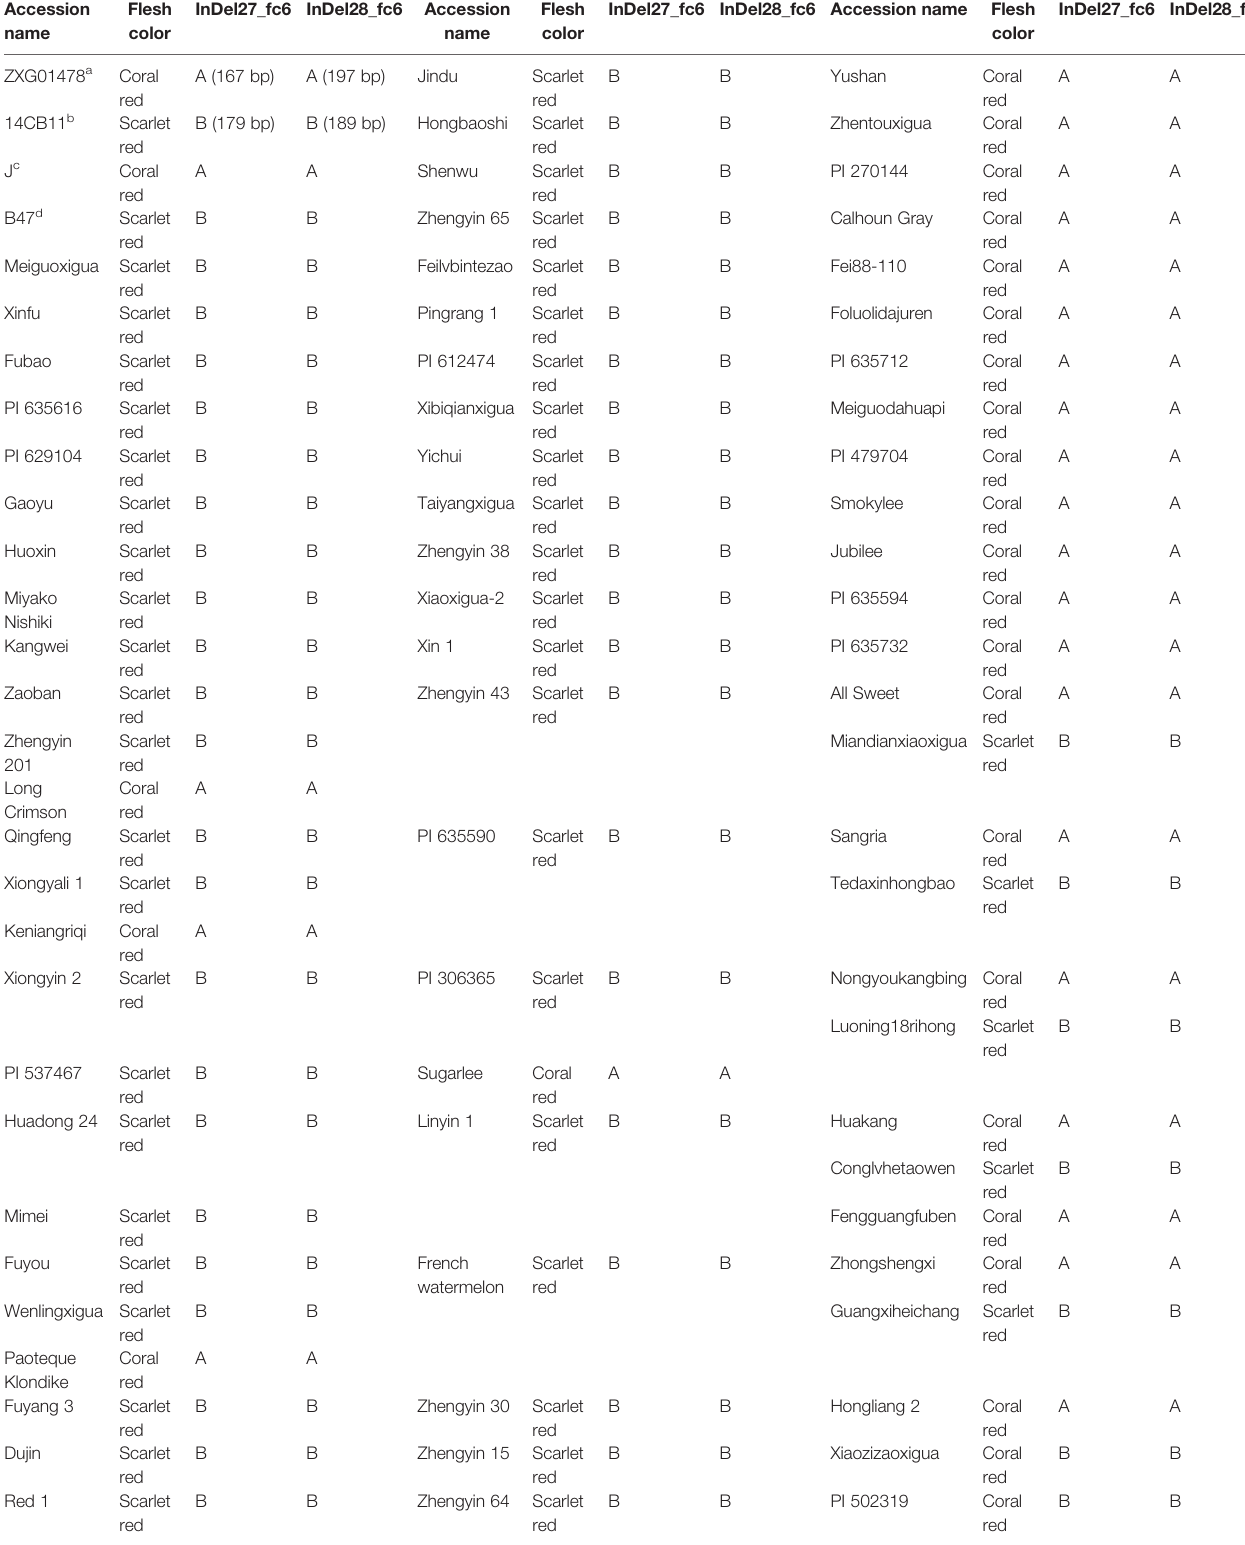
TABLE 3 | Genotype identi fi cation of fl esh color in 87 watermelon germplasm resources and four parental